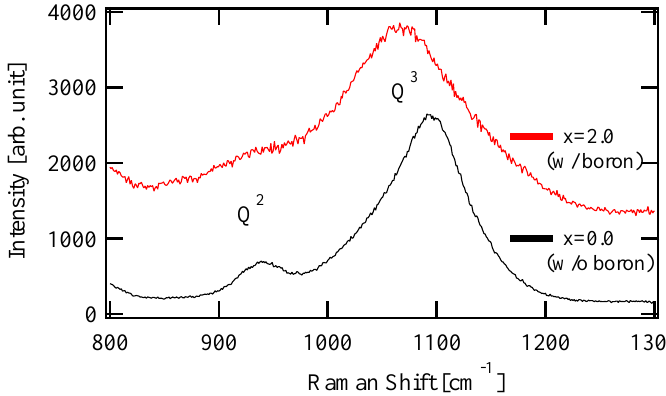
Figure 1. Raman spectra of composition-controlled glass (x = 0.0 and 2.0)